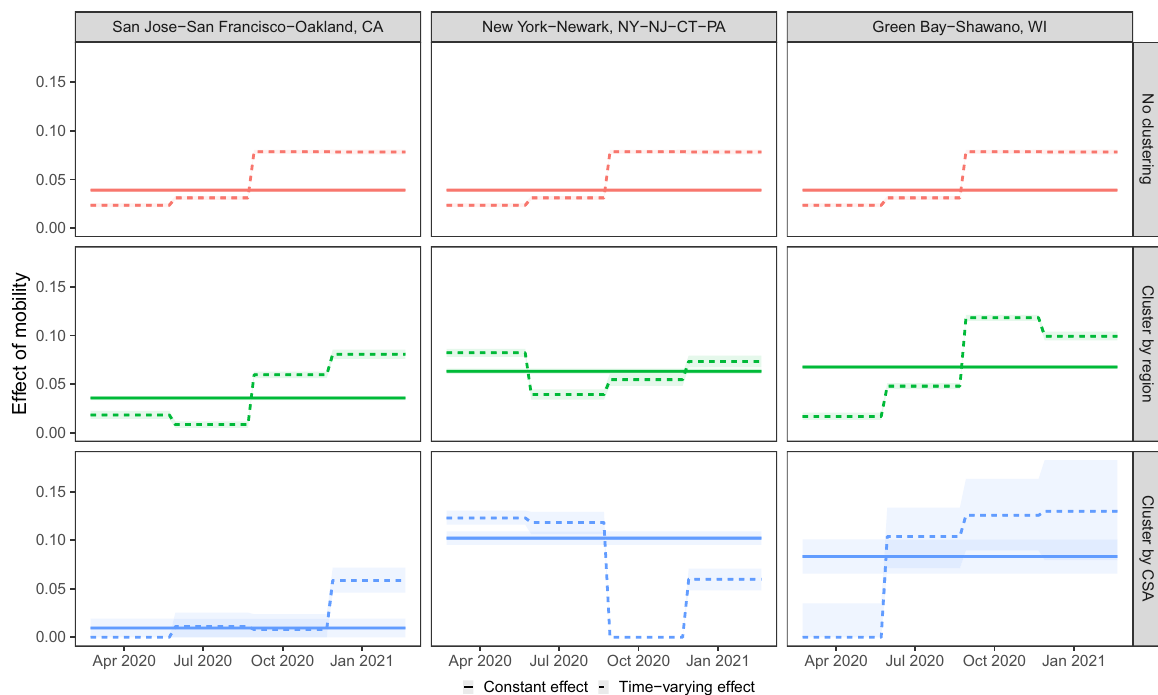
Fig. 7 Overly rigid models average over spatiotemporal effects. The estimated effect of mobility for different spatial clustering (rows) and the form of temporal effects (line type) for three illustrative CSAs are displayed. Median (solid lines) and 95% quantiles (shaded) are shown.